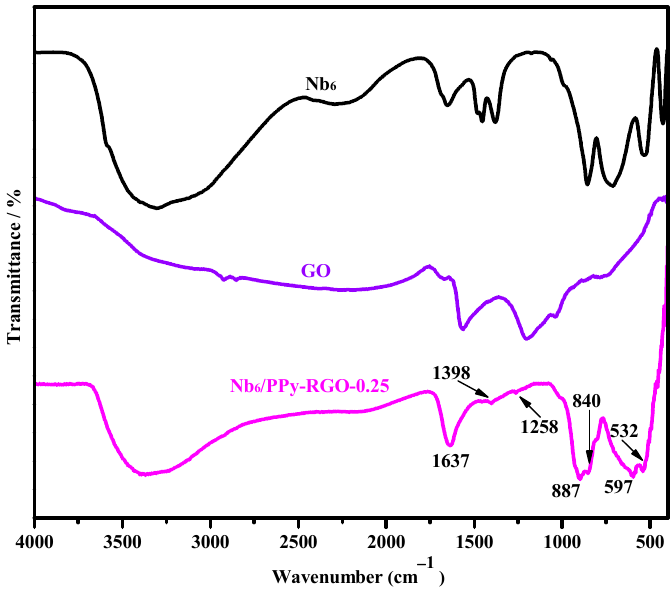
Figure 2. Fourier transform-infrared (FT-IR) spectra of Nb 6 , GO and Nb 6 /PPy-RGO-0.25.